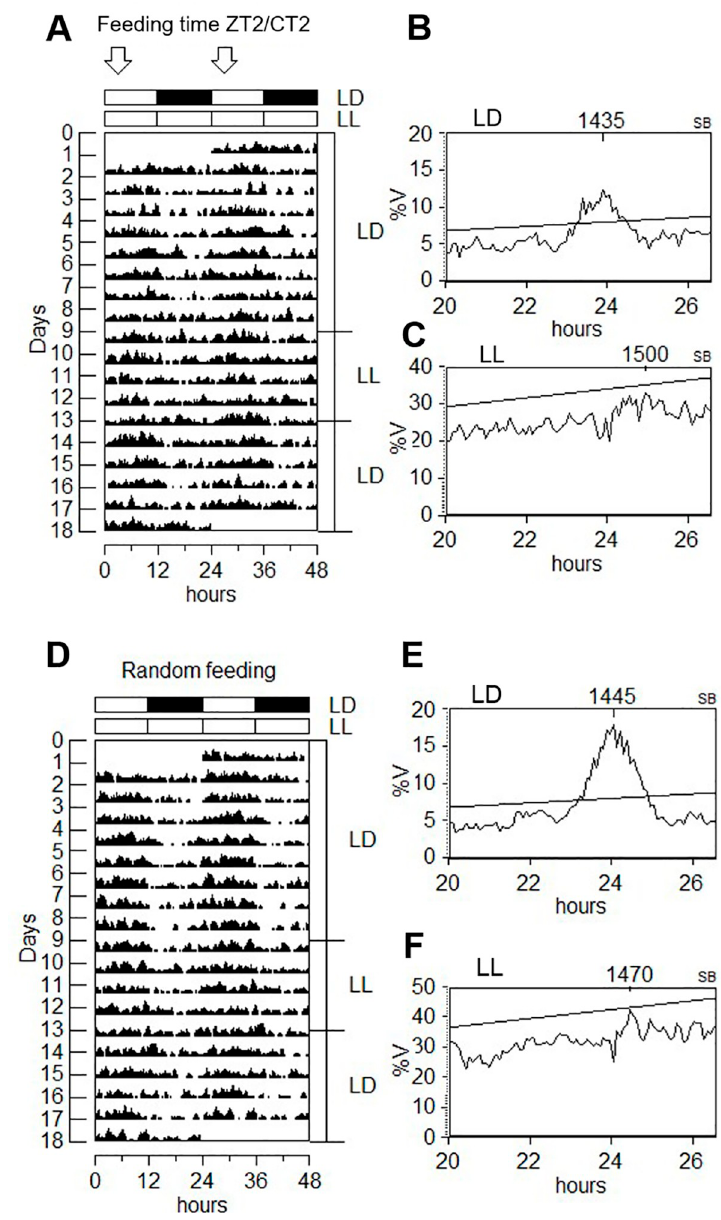
Fig 6. Diurnal locomotor activity from turbot in LD-LL-LD lighting conditions. Recording activity during 18 days is represented by double plot of two consecutive days and represented by actograms (A, D). The white and black bars above the actograms indicate light and dark periods. The arrows above the white bar indicate the time where food is delivered. Fish were kept in LD and fed at ZT2 for 8 days (A), or randomly fed during the light phase (D). From day 9 to 12 fish were in constant light (LL) and then returned to LD. Fish showed daily rhythmicity in activity under LD conditions (B, E), but they were arrhythmic in LL (C, F). Turbot displayed activity during the light phase in LD.